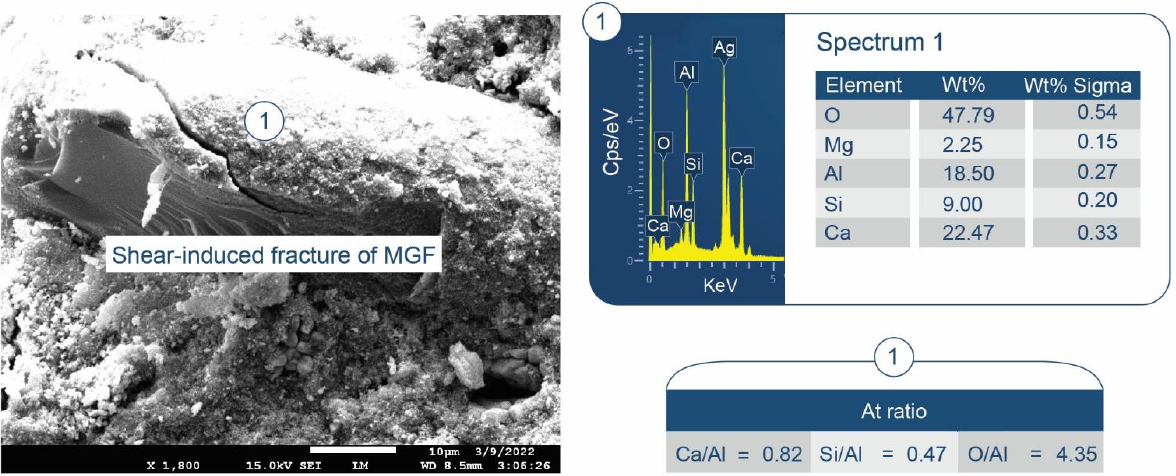
Figure 21. Photomicrograph of PR-changed MGF fiber of 250 ◦ C-autoclaved Ca/MGF